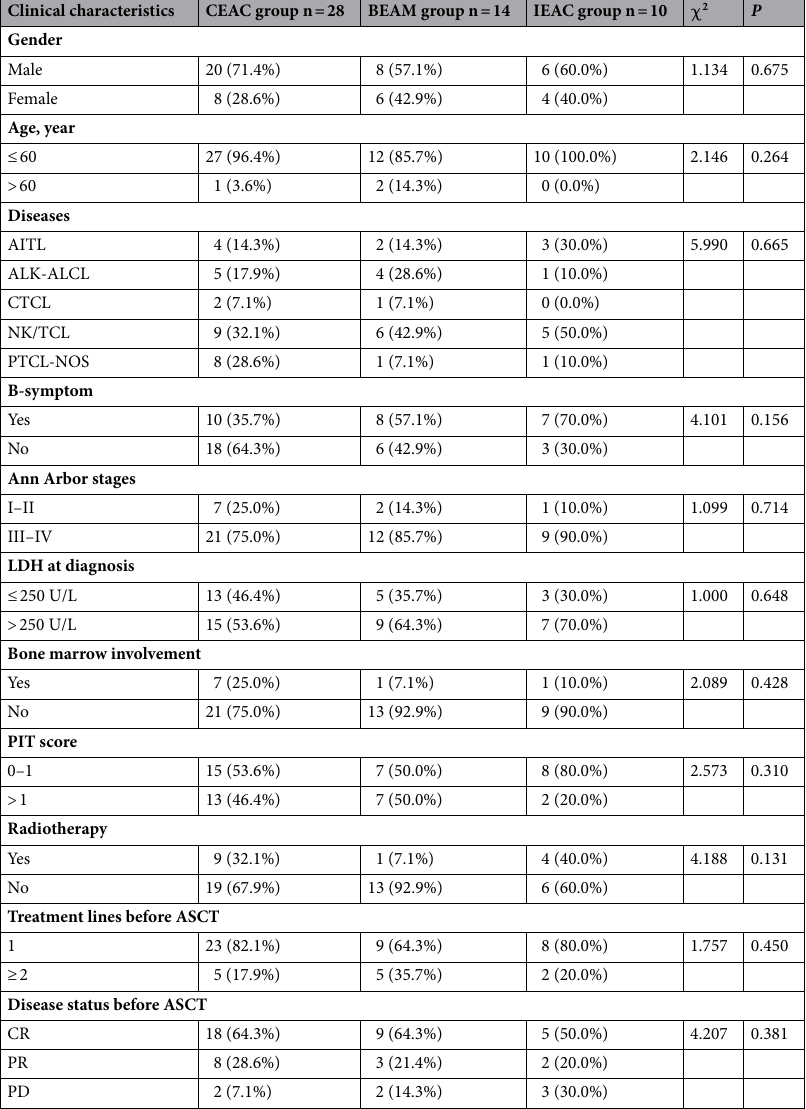
tation. Among the 12 patients with PR before ASCT, 5 had CR, 4 remained in PR, and the remaining 3 had PD at 3 months after transplantation. Among the 7 patients with PD before ASCT, 3 months after transplantation, 1 had CR, 2 had PR and 4 had persistent PD. The early ORR rate was 85.7% (42/49) and there was no significant difference between the three groups ( P = 0.590). Survival analysis. At a median follow-up of 29.1 (0.3–132.1) months, 17 patients (32.7%) had PD and 16